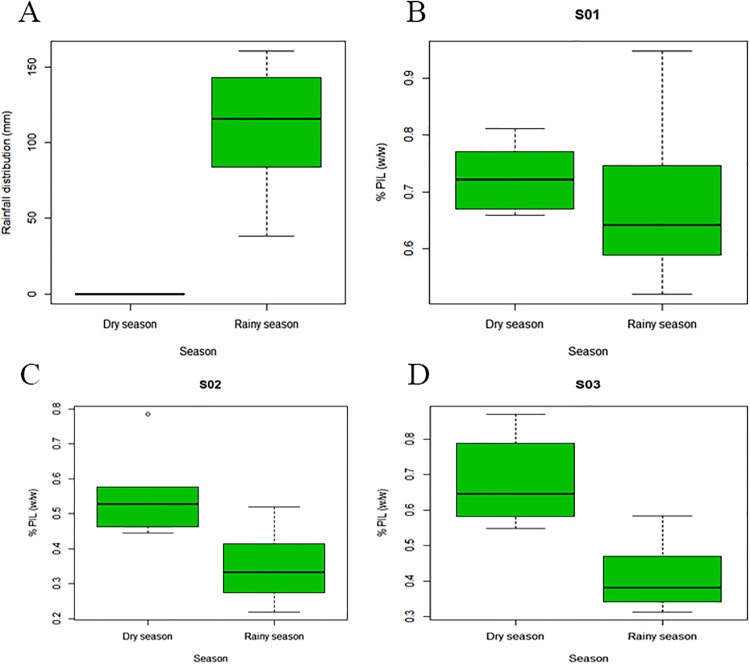
Rainfall and pilocarpine content (%) in the dry and rainy seasons.(A) Rainfall distribution (mm) during the dry and rainy seasons [0.00 mm; 109.69 mm (p = 0.0003), respectively] in a P. microphyllus plantation, Piauí state, northeastern Brazil. (B) Percentage of PIL (w/w) by the dry and rainy seasons [0.727; 0.683 (p = 0.5637), respectively] from S01. (C) Percentage of PIL (w/w) by the dry and rainy seasons [0.560; 0.350 (p = 0.0149), respectively] from S02. (D) Percentage of PIL (w/w) by the dry and rainy seasons [0.687; 0.415 (p = 0.0030), respectively] from S03.